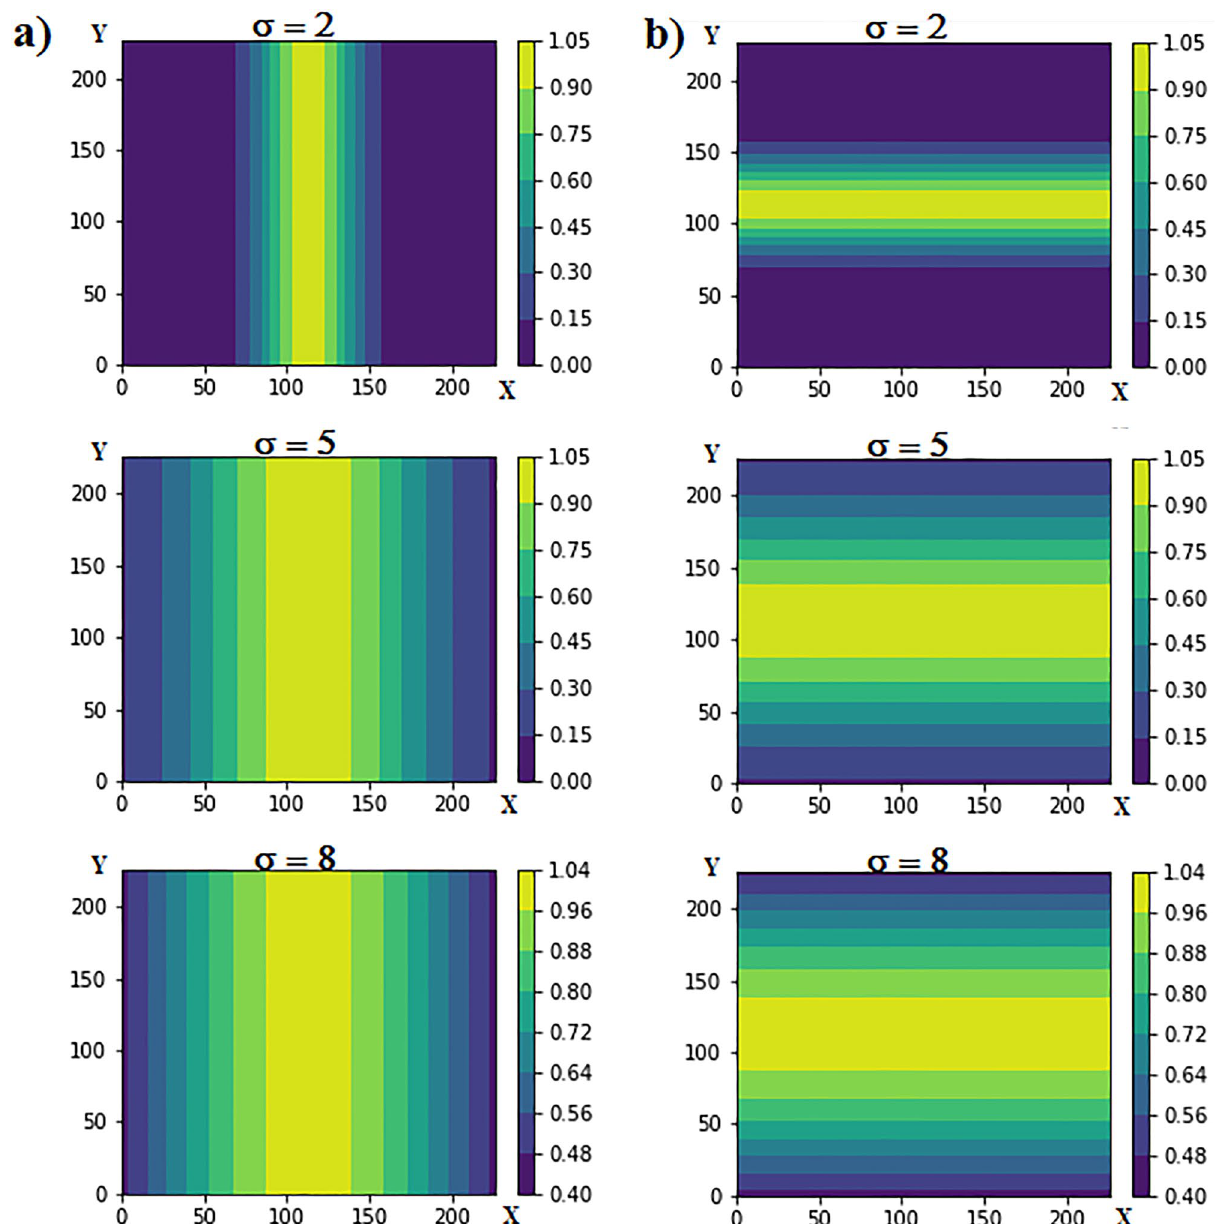
Figure 4. ( a ) Vertical motion filter and ( b ) horizontal motion filter each with w =